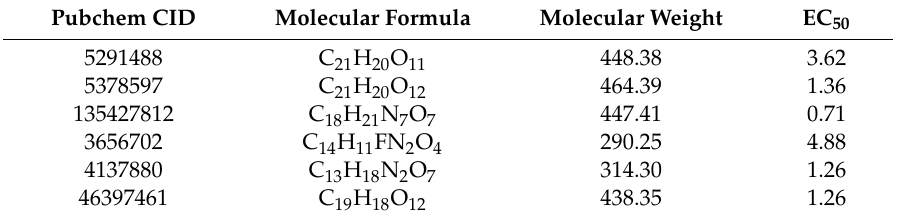
Figure 4. Performance of LBS on data of compound screening. ( A ) Screening accuracy of LBS and NB. ( B ) Precision–recall curve for LBS and NB. The gray-filled part was the screened zone in PC1 of LBS. The AUC (area under curve) of LBS in the screened zone was 0.267 ± 0.004, and the corresponding value of NB was 0.246 ± 0.005. ( C ) Permutation test for LBS. The values of dependent variable were randomly permutated 2000 times to calculate the loss values of LBS. The dashed red line represents the loss value of LBS obtained from the actual experiment ( p = 1.8e − 9 ). Table 1. Compounds proved to be active in binding assay for validation of the screening results by LBS. A compound is regarded as active when the corresponding EC 50 < 5 µ M. More details can be found in Table